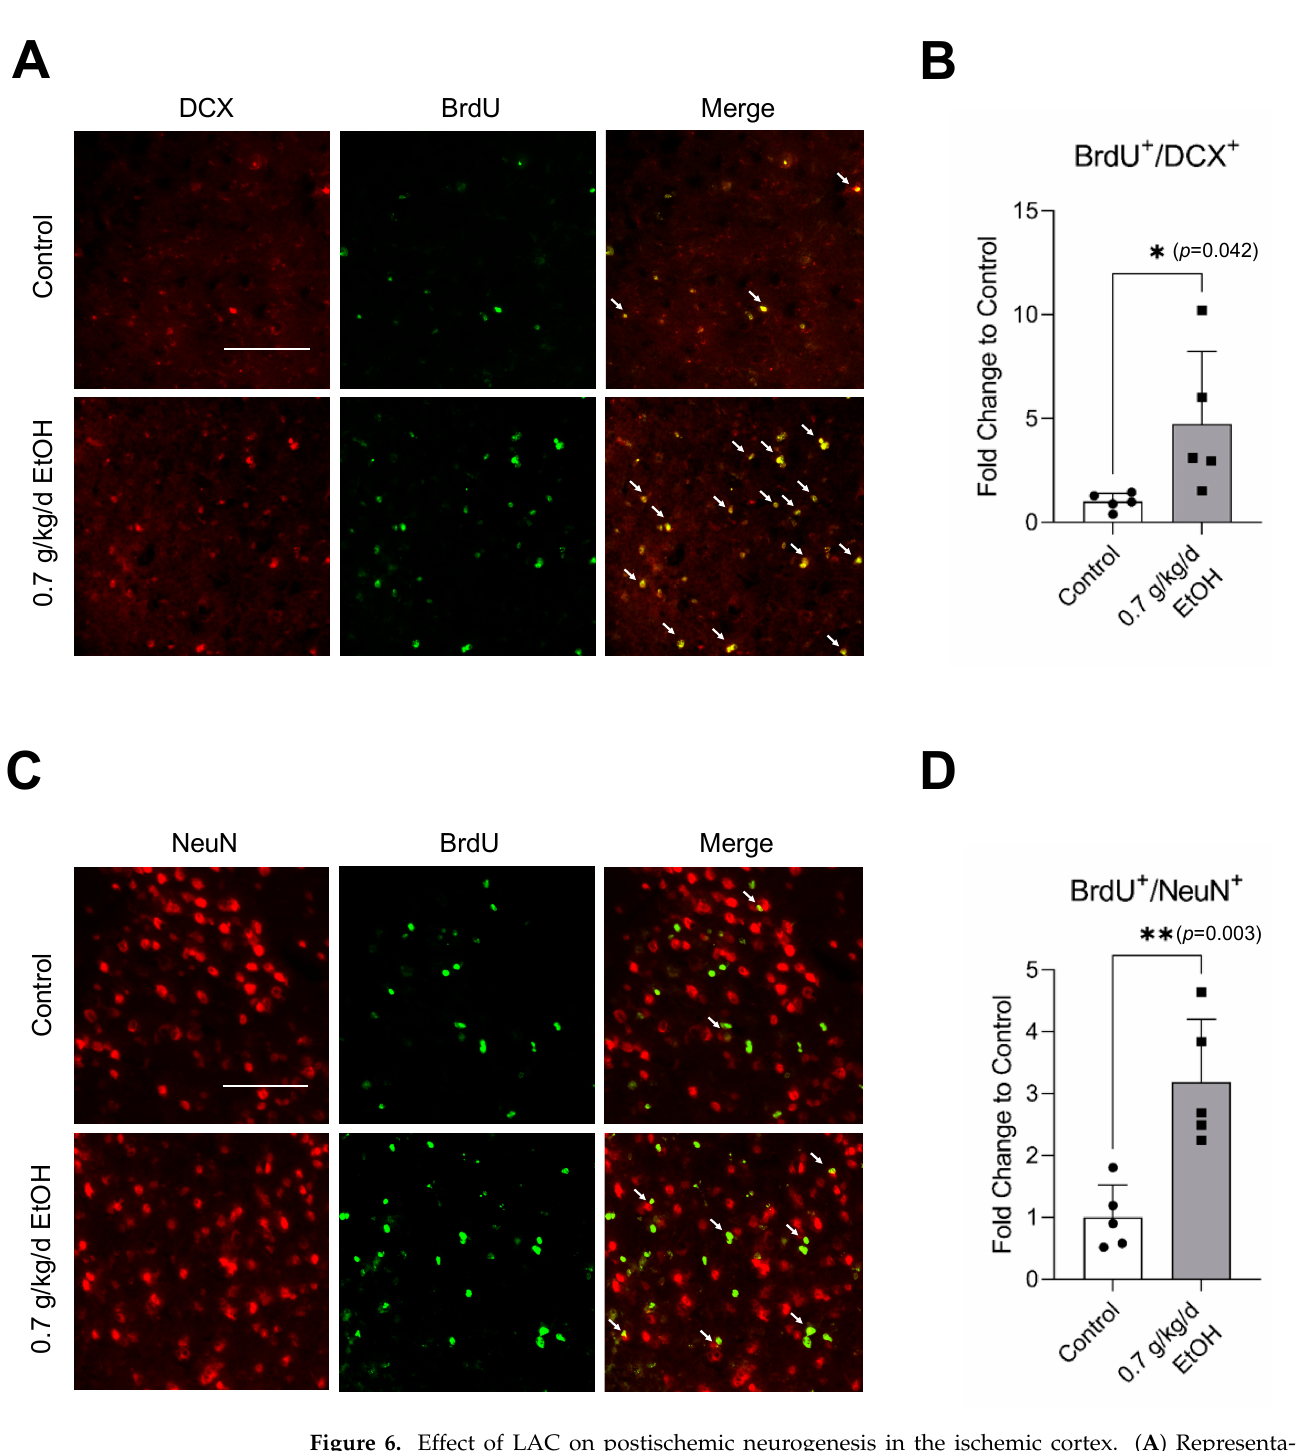
Figure 6. Effect of LAC on postischemic neurogenesis in the ischemic cortex. ( A ) Representative double staining of BrdU and DCX. Scale bar = 100 µ m. ( B ) Values are means ± SD ( n = 5). ( C ) Representative double staining of BrdU and NeuN. ( D ) Values are means ± SD ( n = 5); * p < 0.05; ** p < 0.01 vs. Control. Analyzed using an unpaired t -test.